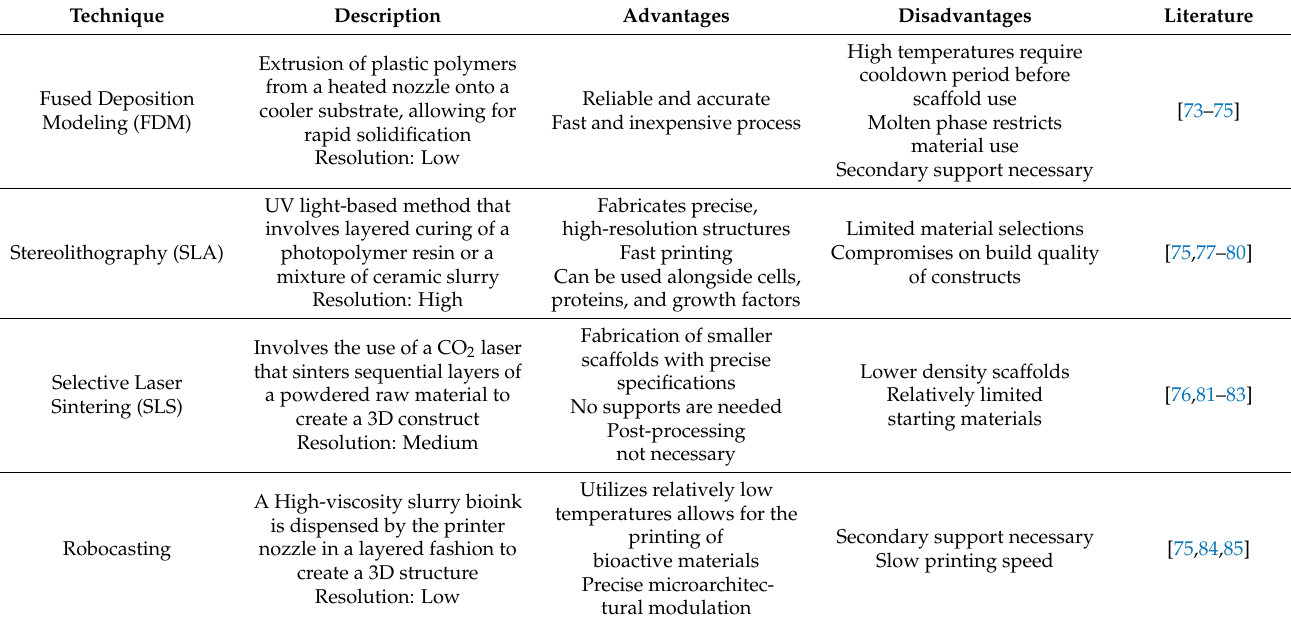
Table 1. Summary of current 3D printing